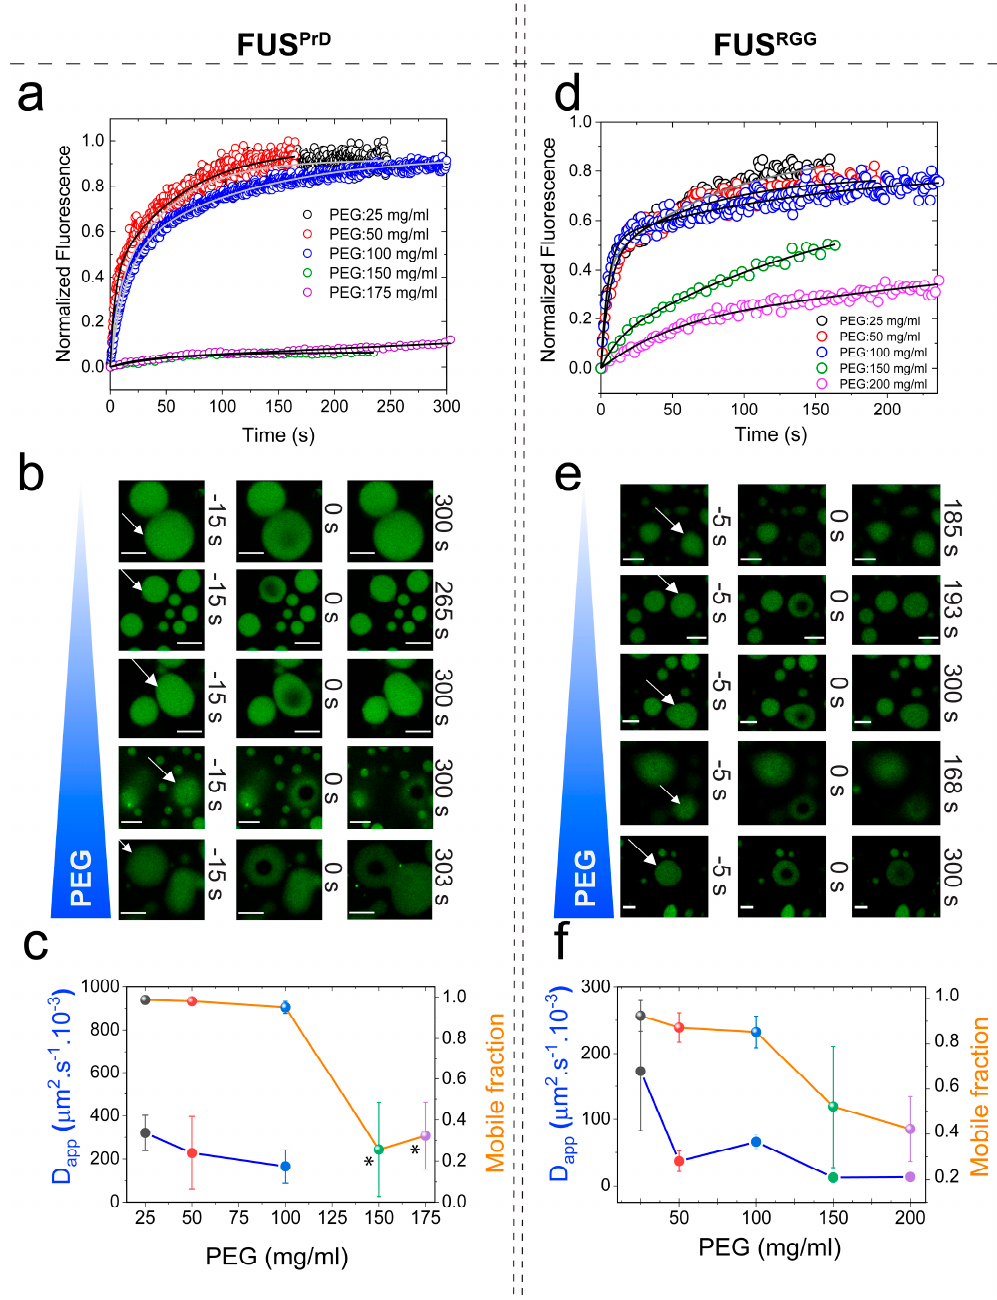
Figure 4. Macromolecular crowding tunes viscoelastic properties of both prion-like and R-rich LCDs. (a , b , d , e ) Representative FRAP plots and images of FUS PrD /FUS RGG droplets at variable concentrations of PEG8000, respectively. Scale bar = 8 µ m in ( b ) and = 4 µ m in ( e ). Negative time implies droplets in pre-bleaching state in ( b , e ). ( c , f ) Analyses of the FRAP data estimating apparent diffusion coefficients (D app ) of respective LCDs within the condensed phase ( left axis, blue ) and the mobile phase fraction ( right axis, orange ) in respective cases. Due to a very low fraction of recovery, D app estimation from the FRAP data for FUS PrD droplets at 150 and 175 mg/mL PEG was omitted (indicated by the asterisks in ( c